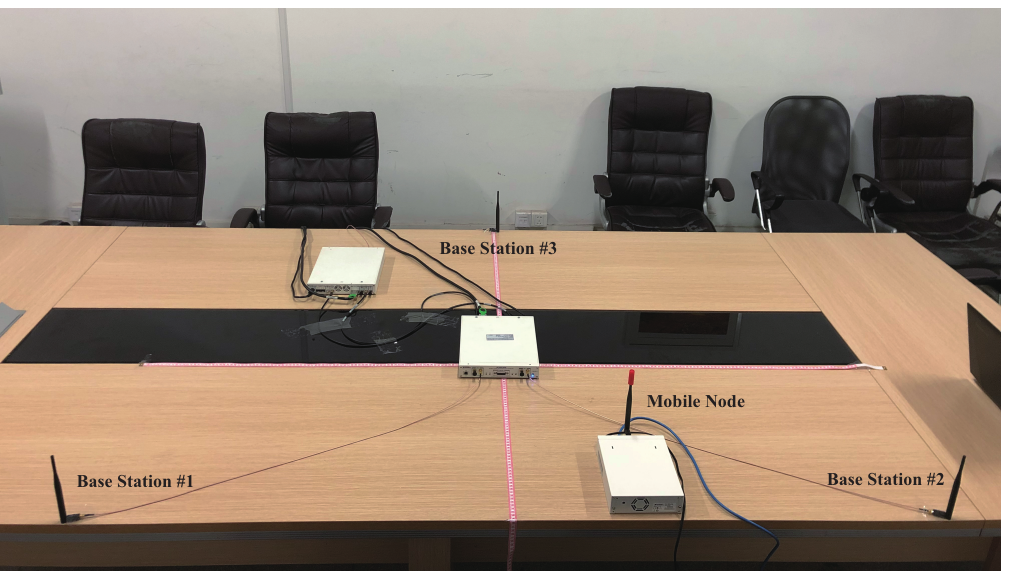
Figure 14. 2D position sensing experimental setup to validate the proposed method.